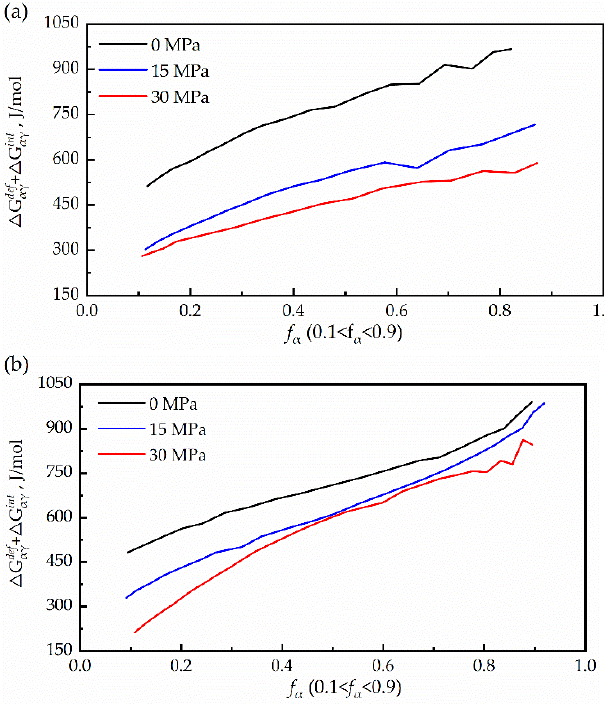
Figure 10. The sum of misfit-accommodation energy and interface energy as a function of transformed fraction. ( a ) 25 K/min; ( b ) 50 K/min.